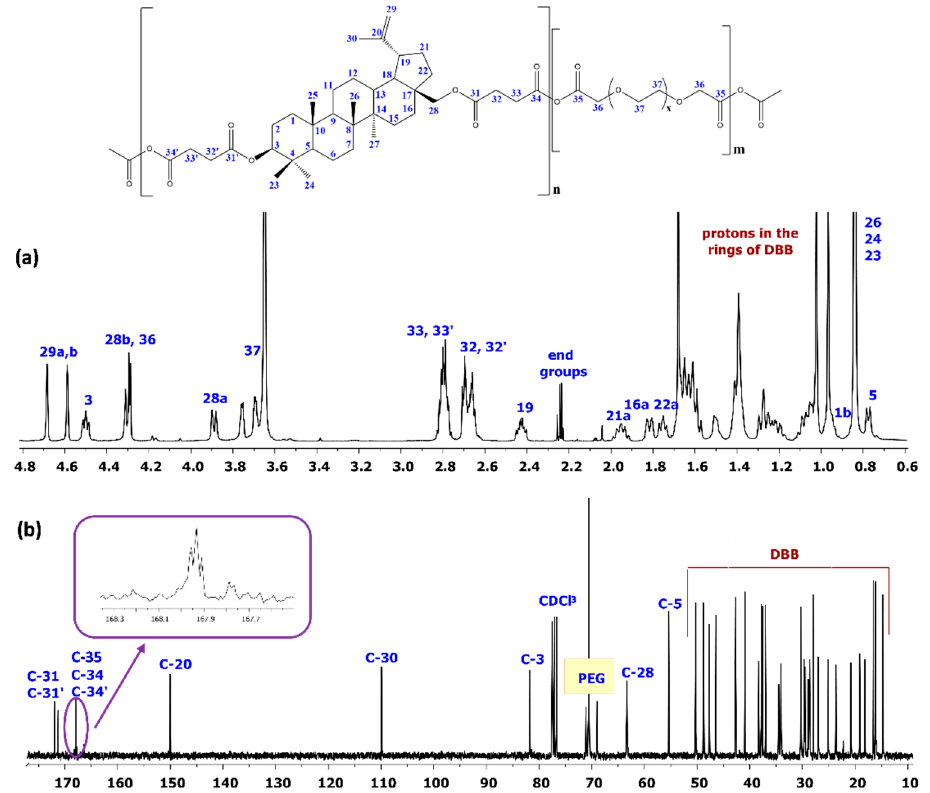
Figure 2. 1 H NMR and 13 C NMR spectra of polyanhydrides based on betulin disuccinate and dicarboxylic derivatives of PEG. ( a ) 1 H NMR spectrum; ( b ) 13 C NMR spectrum.